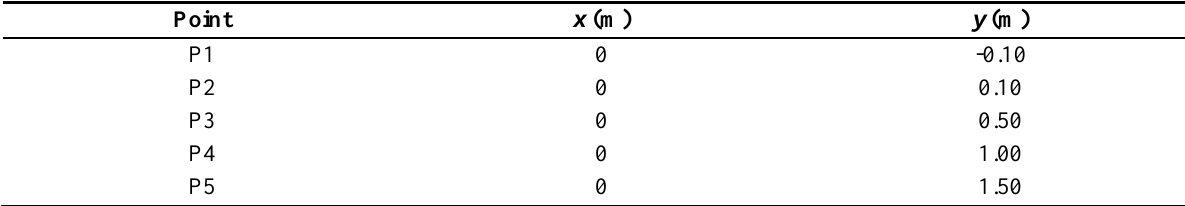
Positions of five points across the